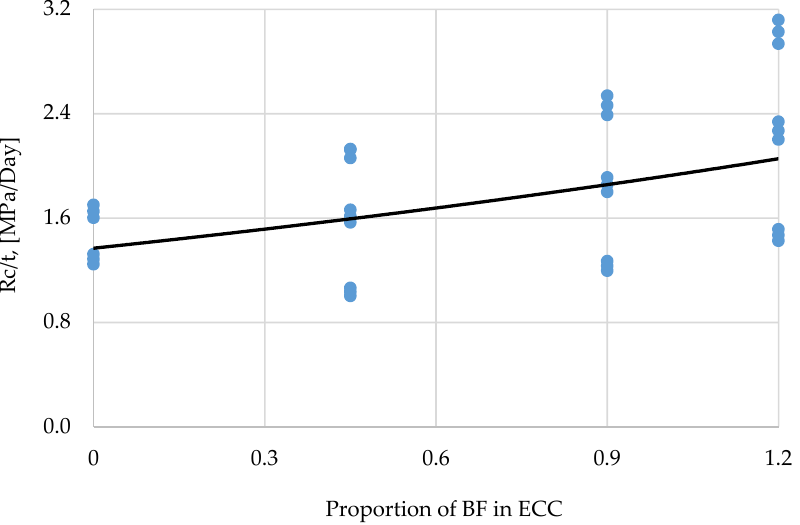
Figure 5. Dependency of the compressive strength of ECC depending on the percentage of BF and the curing period.